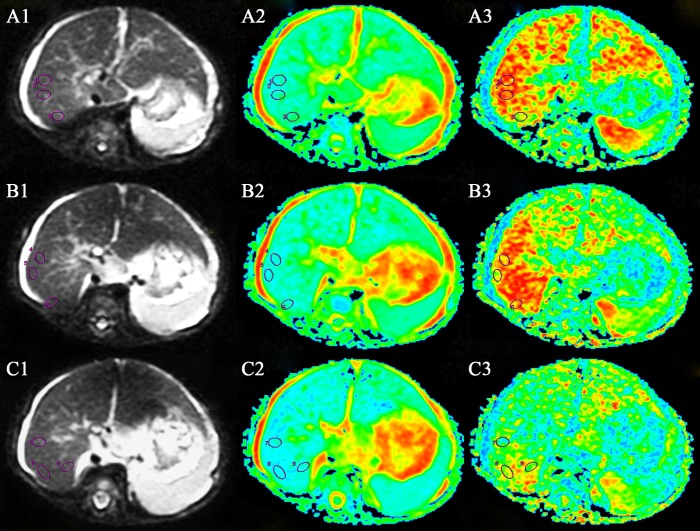
Measurement of the apparent diffusion coefficient and fractional anisotropy on diffusion tensor imaging reconstructed images.A 165-day-old female infant with biliary atresia. Three regions of interest were drawn on each original image (b = 0), and three consecutive images (A1, B1 and C1) above the hepatic porta were included. The mean ADC values were obtained from the nine total ROIs on the ADC map (A2, B2 and C2), and the mean FA values were obtained from the FA maps (A3, B3 and C3).